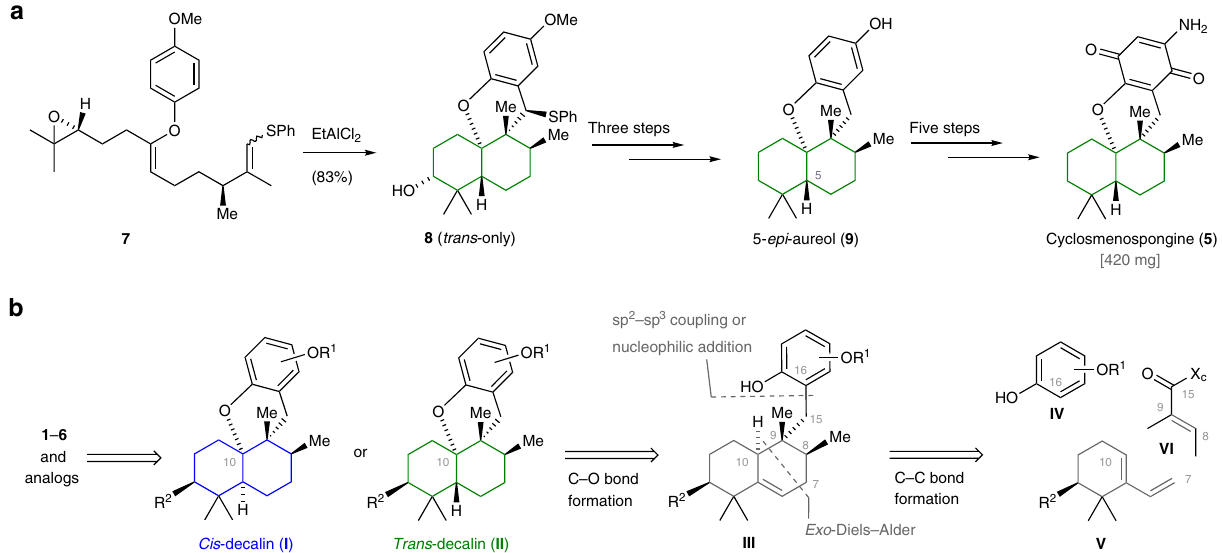
Fig. 2 Strategies for the construction of tetracyclic meroterpenoids. a The polyene cyclization reaction of aryl enol ether 7 enabled rapid assembly of the trans -decalin substructure of 5- epi- aureol ( 9 ) and cyclosmensopongine ( 5 ). However, this strategy could not be adapted for the preparation of meroterpenoids containing a cis -decalin subunit. b Synthesis of the 5,6-dehydrodecalin intermediate III should be accomplished by a highly modular, three- component coupling strategy of phenol IV , diene V , and dienophile VI . The ability to construct both cis - and trans -decalins from a common precursor would allow for the synthesis of 1 – 6 and a variety of non-natural derivatives for biological screening. Color coding: blue, cis -decalin, green, trans -decalin. R 1 = alkyl, R 2 = H or OBn, X c = chiral